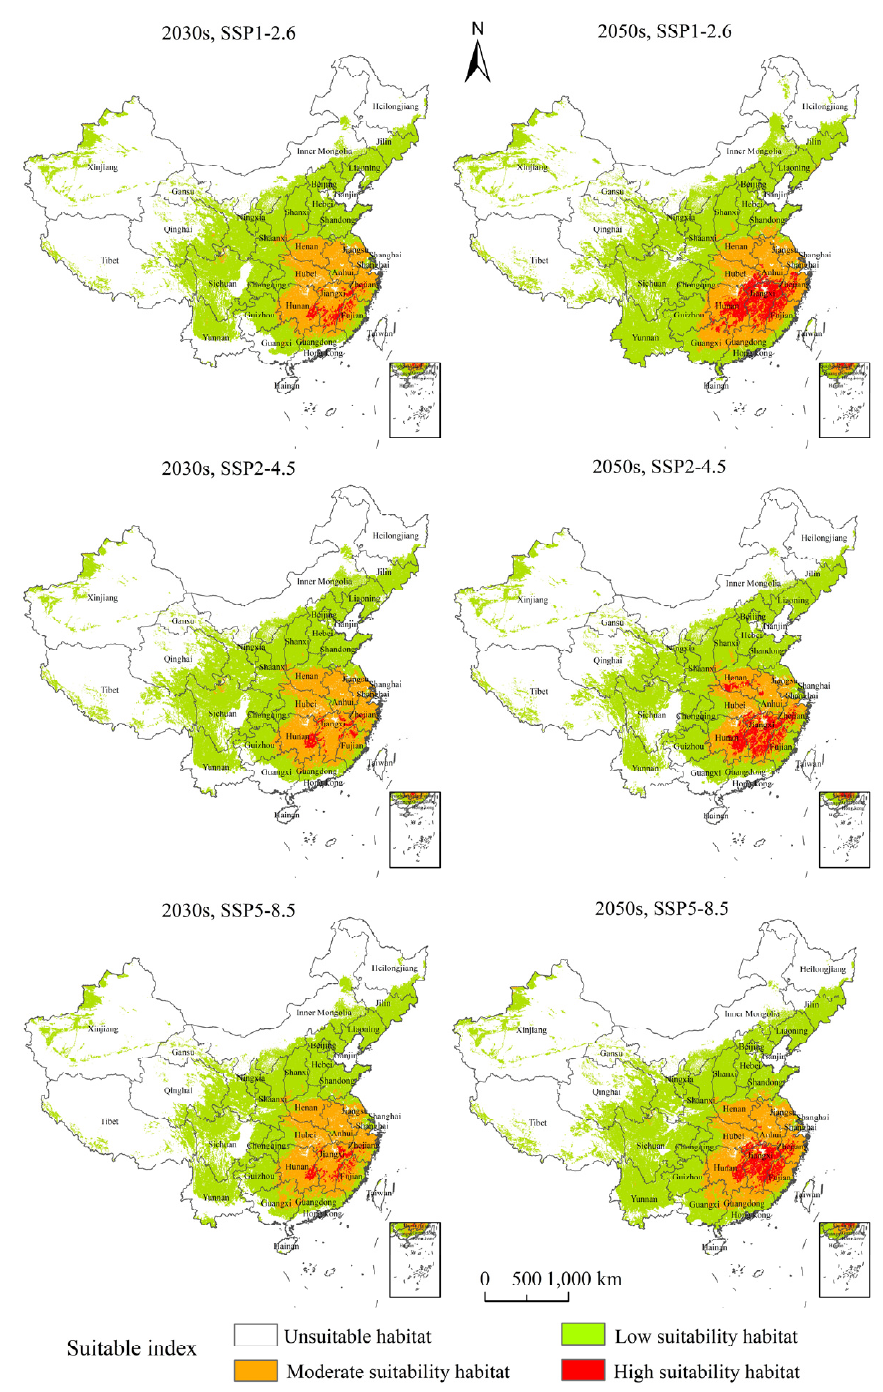
Figure 7. Potential suitable habitats of Helicoverpa zea under different climate change scenarios during the 2030s and 2050s in China. Note: SSP: shared socioeconomic pathways (see Table 2).